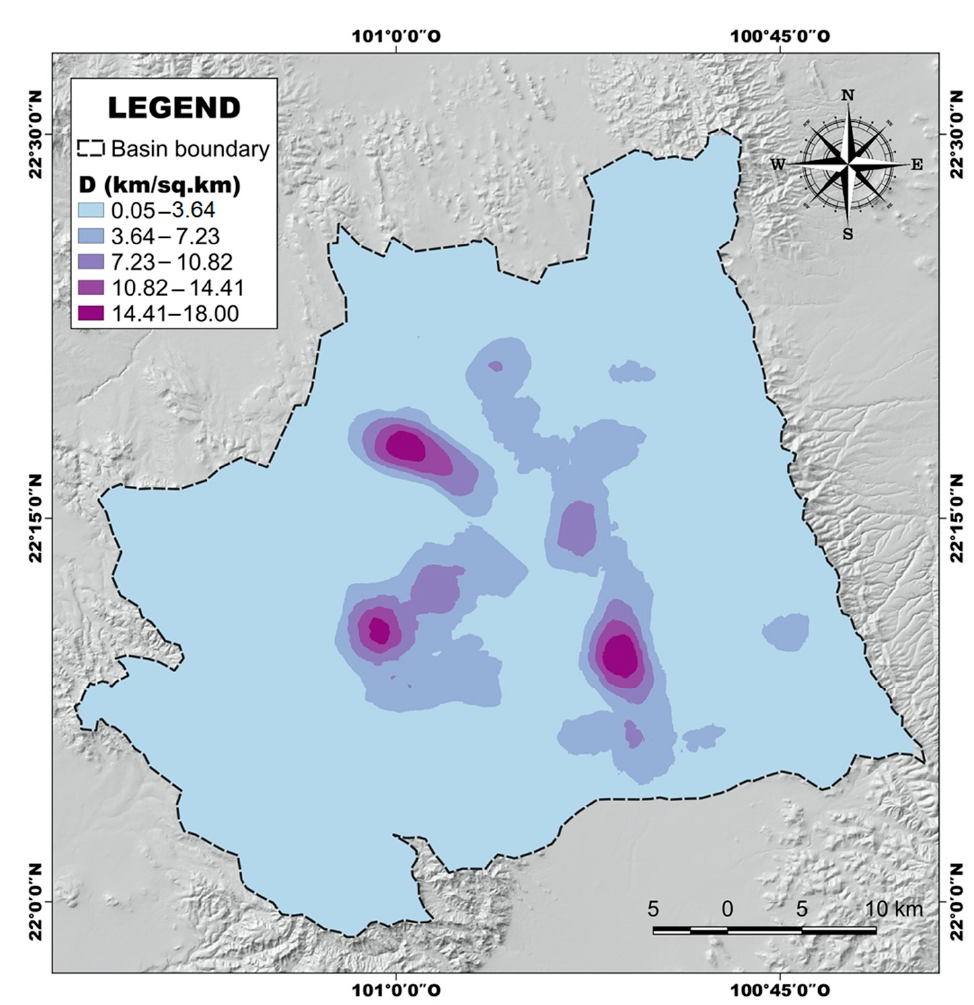
Figure 7. Drainage Density (D) map of the San Luis Potosi Basin.